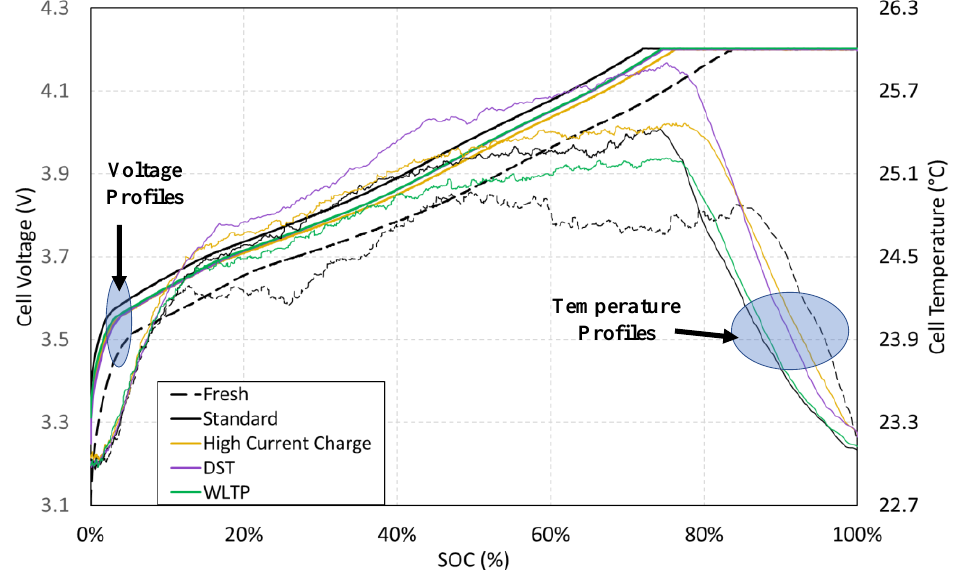
Figure 5. Cell voltage and temperature evolution at standard charging for fresh and all cycled cells.